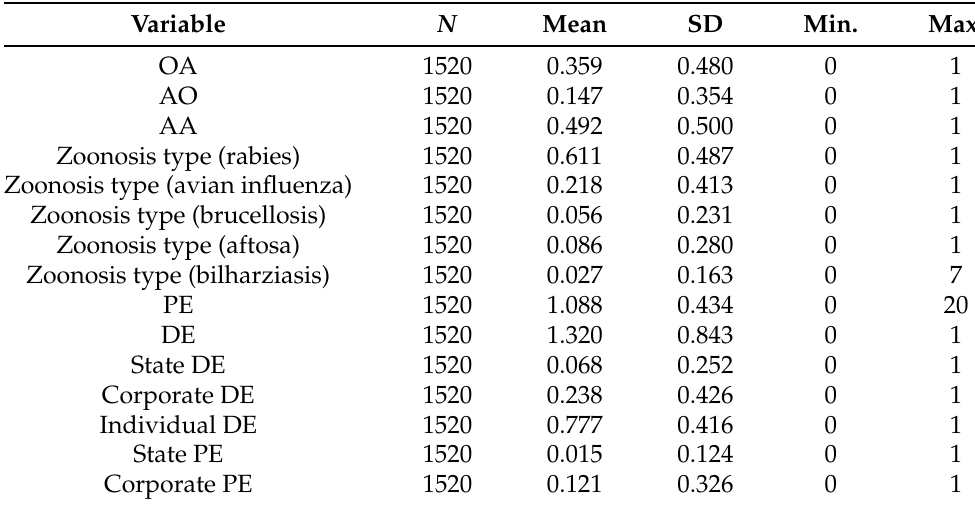
Table 4. Descriptive statistics for the independent and control